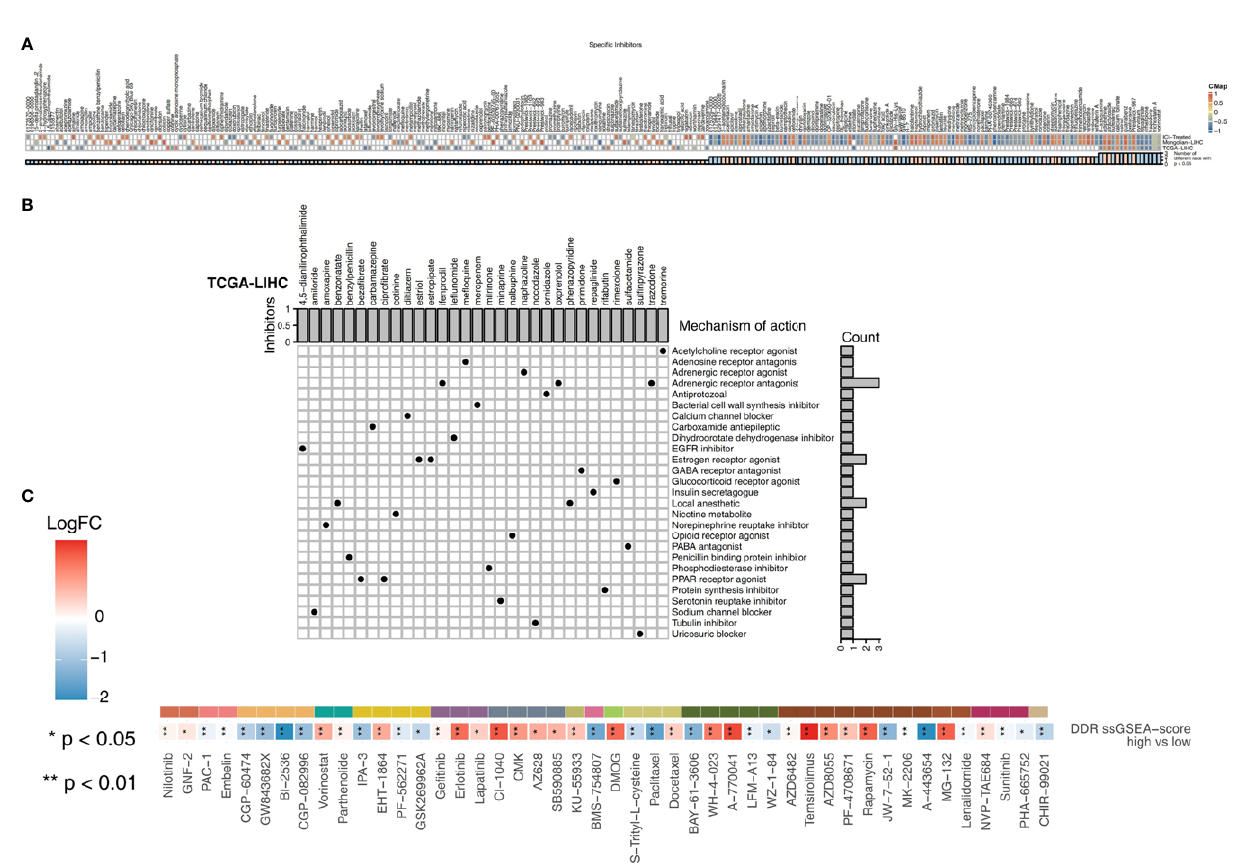
FIGURE 6 | (A) Heatmap showing the enrichment scores (positive in blue and negative in red) of each compound from the CMap analysis of the TCGA-LIHC, Mongolian-LIHC and ICI-treated cohorts. The enrichment score (ES) ranged from -1 (negative connectivity) to 1 (positive connectivity). (B) Heatmap showing each compound from the CMap analysis that shares MoAs (rows) sorted by the number of compounds with shared MoAs in the remaining high DDR score and low DDR score tumors. (C) Heatmap depicting the mean differences in IC50 values between two molecular subclasses (high DDR score and low DDR score tumors) in the TCGA-LIHC cohort. The y-axis indicates the drug names. Each square represents the fold change of or difference in each indicated IC50 value between high DDR score and low DDR score tumors in the TCGA-LIHC cohort. Red indicates upregulation, while blue indicates downregulation. The drug types are shown on the